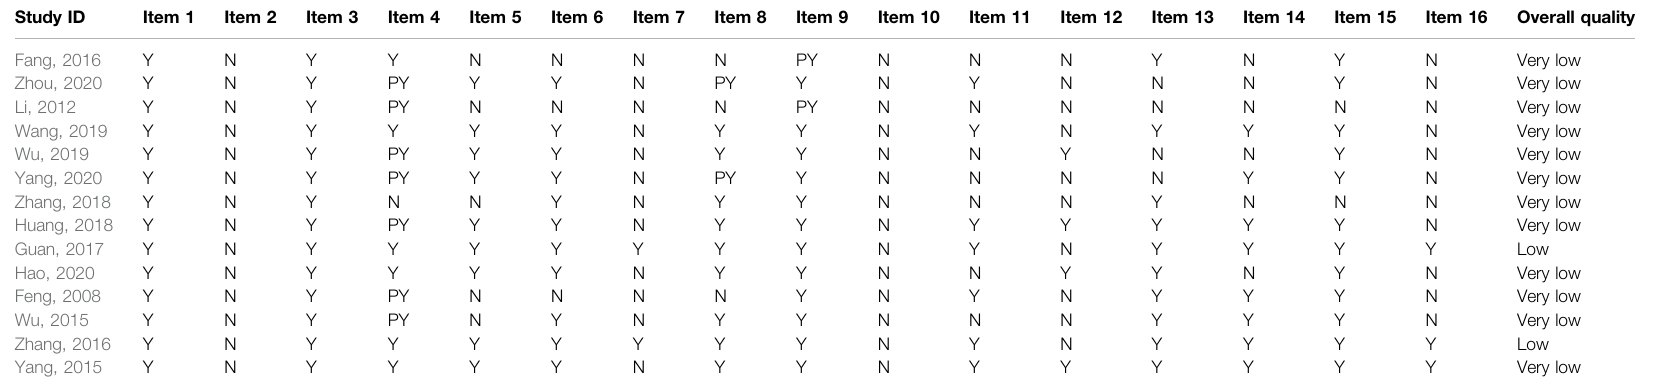
TABLE 3 | Results of AMSTAR 2